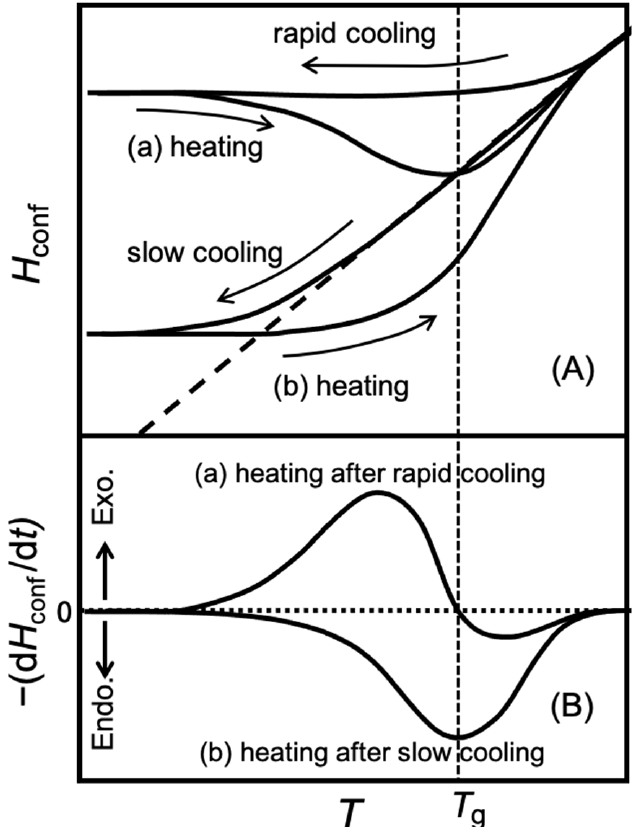
Figure 4. Schematic presentation of typical temperature dependence of the configurational enthalpy H conf of the molecule near the glass-transition temperature ( A ) and the spontaneous enthalpy-relaxation rate –(d H conf /d t ) observed in the heat-capacity measurement ( B ) [10]. The dashed line in ( A ) indicates the equilibrium enthalpy. The vertical dashed line indicates the glass-transition temperature T g .